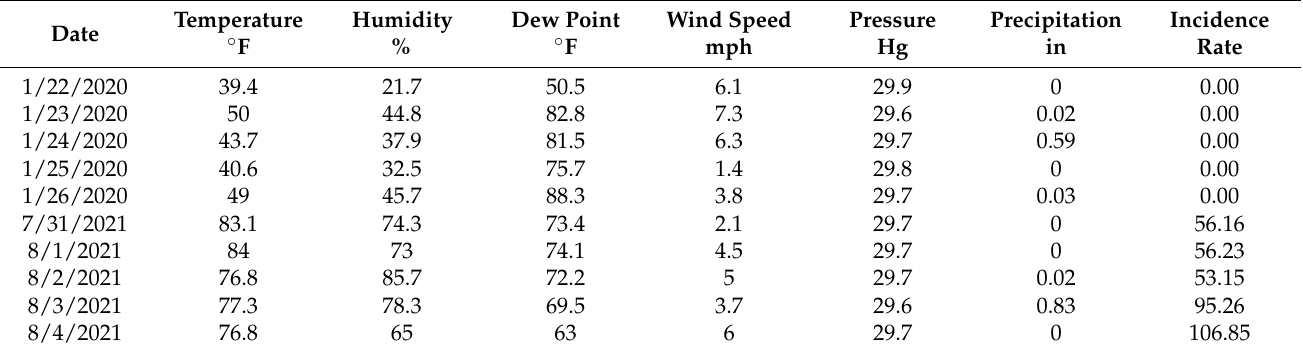
Table 1. A sample of data set collected—COVID-19 incidence rate and weather data over